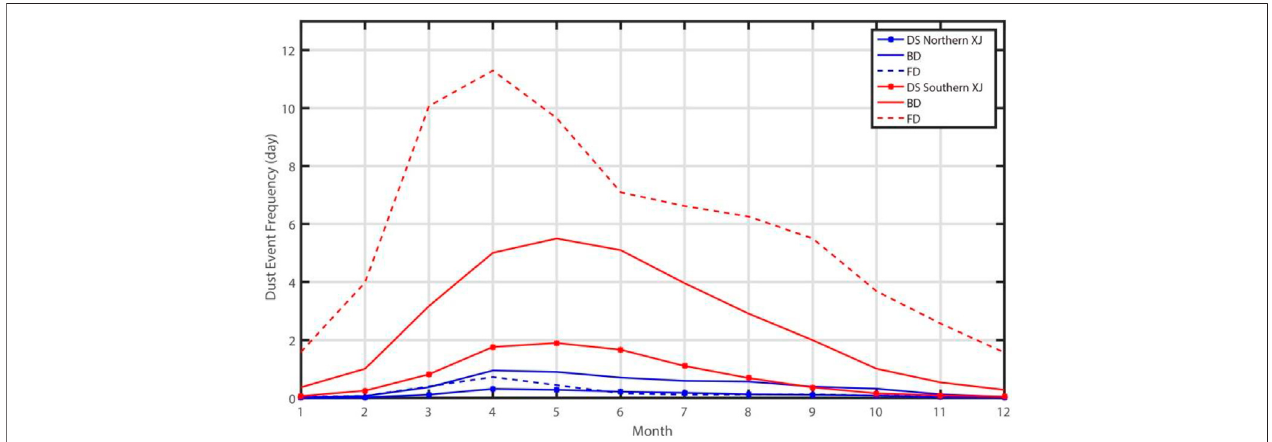
FIGURE 2 | Monthly average occurrence days of dust storm, blowing dust and fl oating dust during 1960 – 2015.